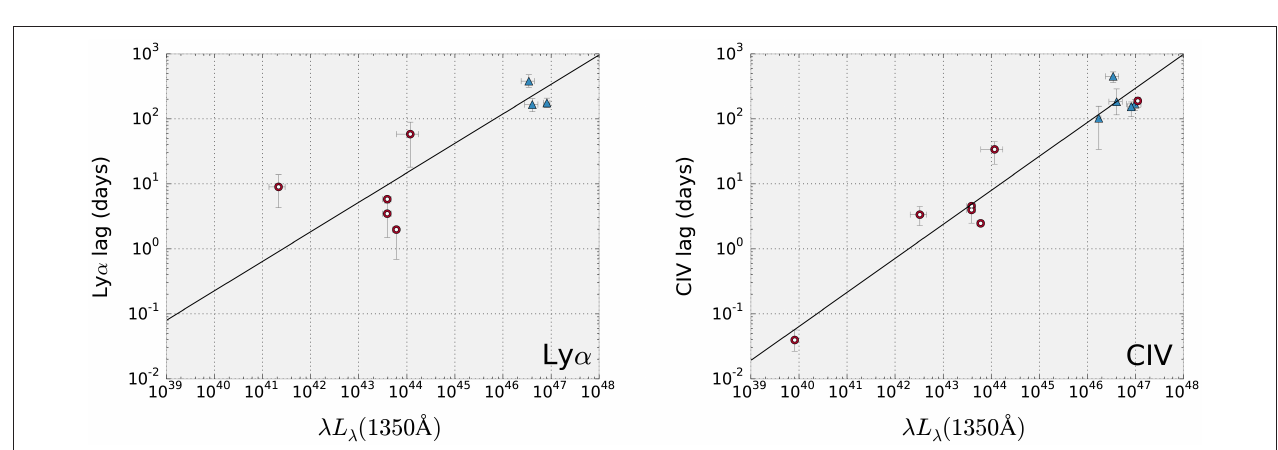
FIGURE 2 | Shifted and normalized continuum and emission line light curves for CT286 (Left) and J221516 (Right) . The time axis is expressed in Julian Dates - 2,450,000 days. R-band continuum, Ly α , and CIV light curves are presented using circles, triangles, and squares, respectively.